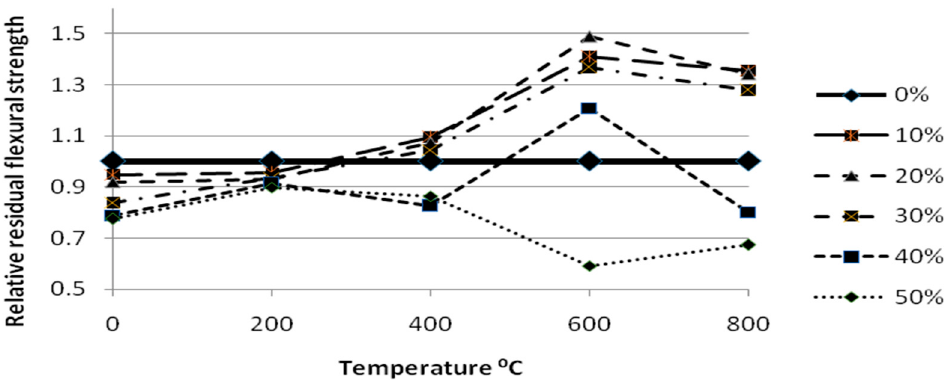
Figure 14. Relative residual flexural strength of gradually cooled SCGM at high temperature.